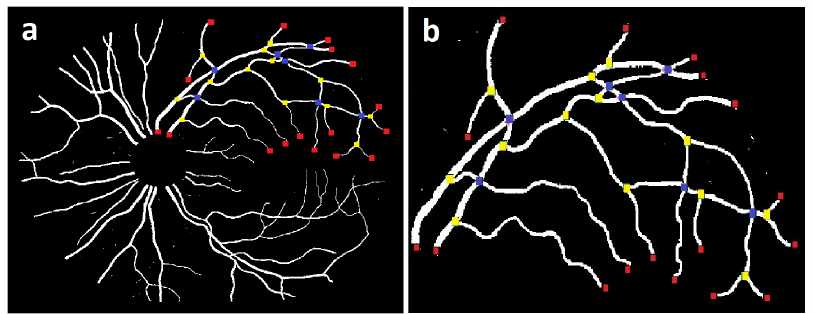
Figure 4. Image example: a) Vessel network b) Vessel tree [Vessel width is enlarged for visualization].